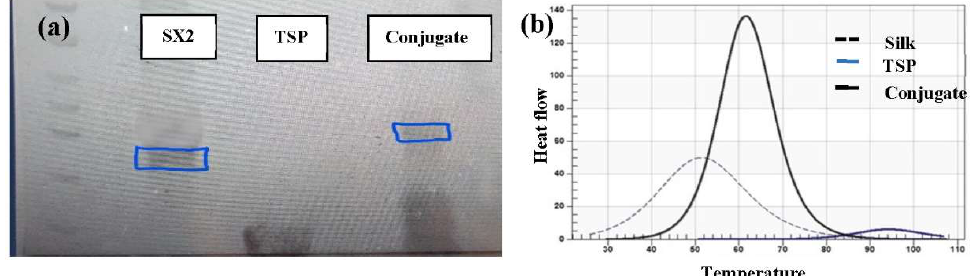
Figure 4. ( a ) SDS PAGE showing the molecular weight difference between silk and the conjugate, ( b ) DSC graph of silk, TSP and the conjugate showing increase in enthalpy of the conjugate.